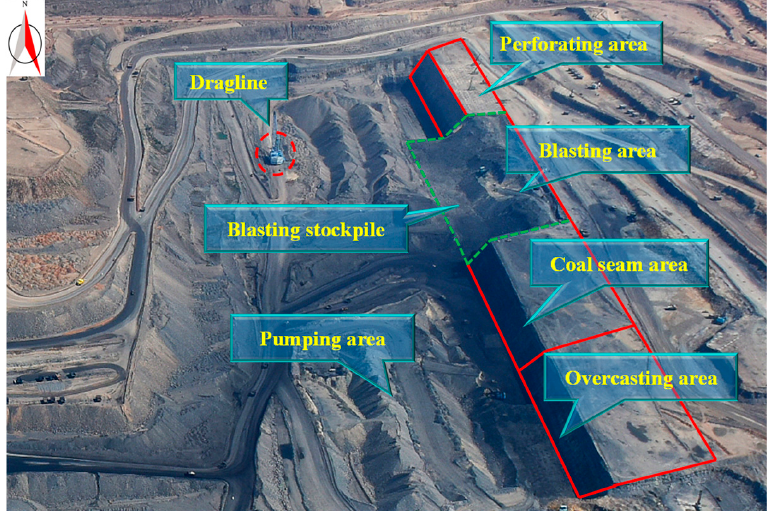
Figure 1. Aerial view of operating area in Heidaigou open-pit mine in 2022.